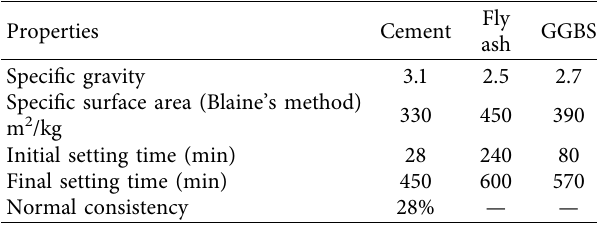
Table 6: Physical properties of the binding material.